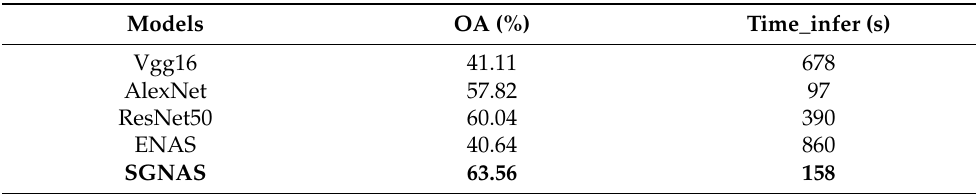
Table 5. Overall accuracy and inference time of the cross-domain scene classification of different models for NWPU-RESIST45 → RSSCN7.